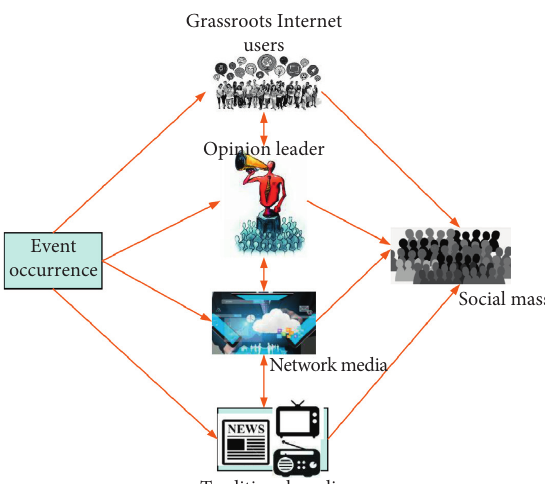
Figure 3: Ways of spreading online public